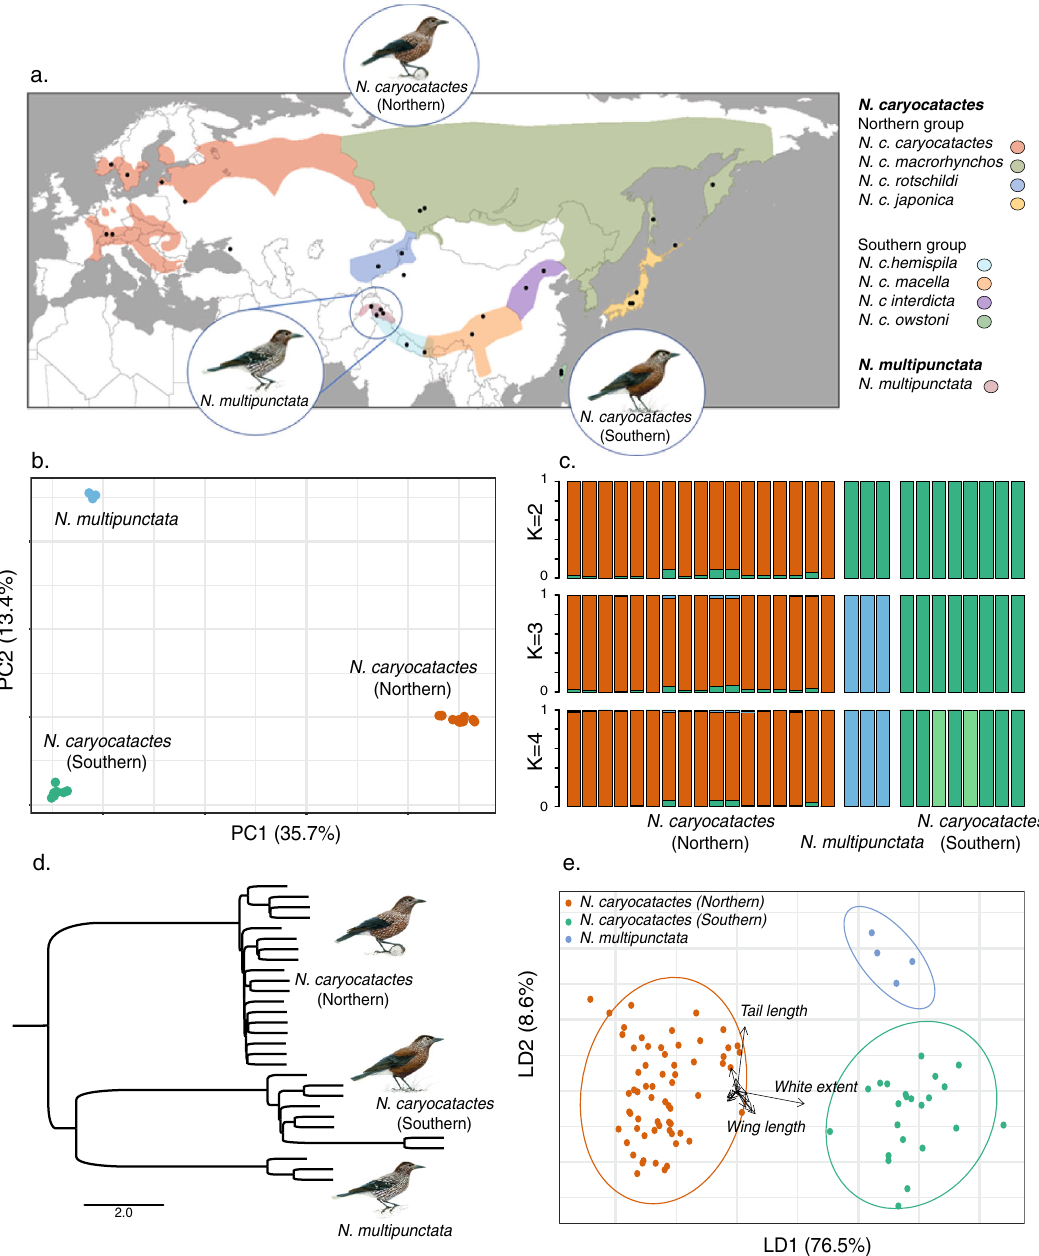
Fig. 1 Genomic and morphometric analyses of the Eurasian nutcracker species complex. a Species range according to Madge et al. 35 and Gill et al. 34 with sampling locations (black dots) of N. caryocatactes (northern) ( N = 17), N. caryocatactes (southern) ( N = 8) and N. multipunctata ( N = 3). Subspecies distributions are depicted in different colours according to the legend. b Principal component analysis based on 110,979 SNPs separated the data in three distinct clusters. c Population structuring based on admixture analysis for K ranging from 2 to 4. Cross-validation indicates K = 3 as the optimal number of clusters. d Species tree under the Multiple Species Coalescence model constructed from 192 nuclear genomic alignments of 1 Mbp. e Linear discriminant analysis of phenotypic variation among Eurasian nutcrackers based on an independent morphometric dataset of 90 museum specimens. Bird images by Jon Baldur Hlidberg, courtesy of the